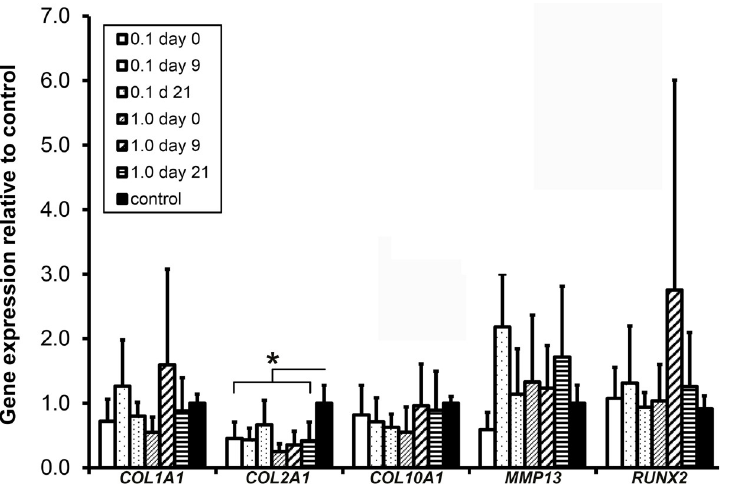
Fig 1. Gene expression of type I, II and X collagen ( COL1A1 , COL2A1 , COL10A1 ), matrix metallopeptidase 13 ( MMP13 ) and runt related transcription factor 2 ( RUNX2 ) by human chondrocytes cultured for 28 days in the presence of 0.1 or 1.0 μ M PTH from day 0, 9 or 21 onwards. Controls did not receive PTH. 0.1 or 1 μ M PTH was added from day 0, 9 or 21 onwards. � : p = 0.042. Graphs show mean ± 95% C-I. n = 6.